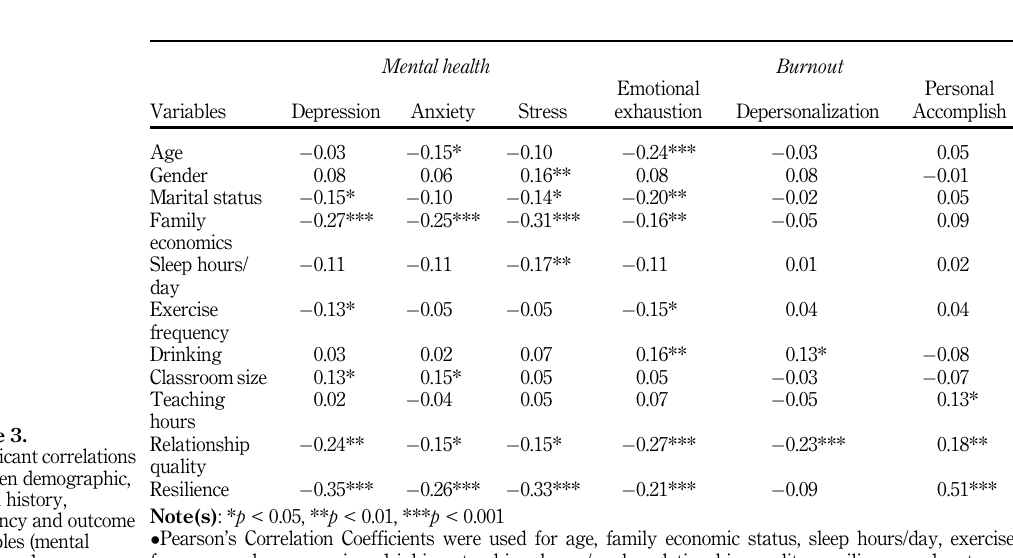
among teachers ( N 5 267)